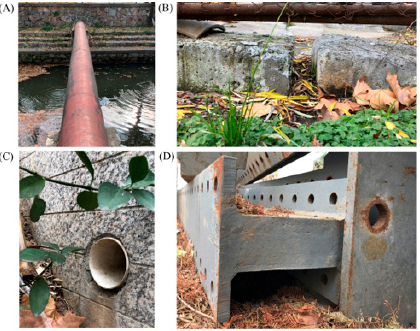
Figure 1. Typical unstructured environments. ( A ) Outer surface of pipe; ( B ) environment with restricted width; ( C ) inner surface of pipe; ( D ) environment with restricted height.